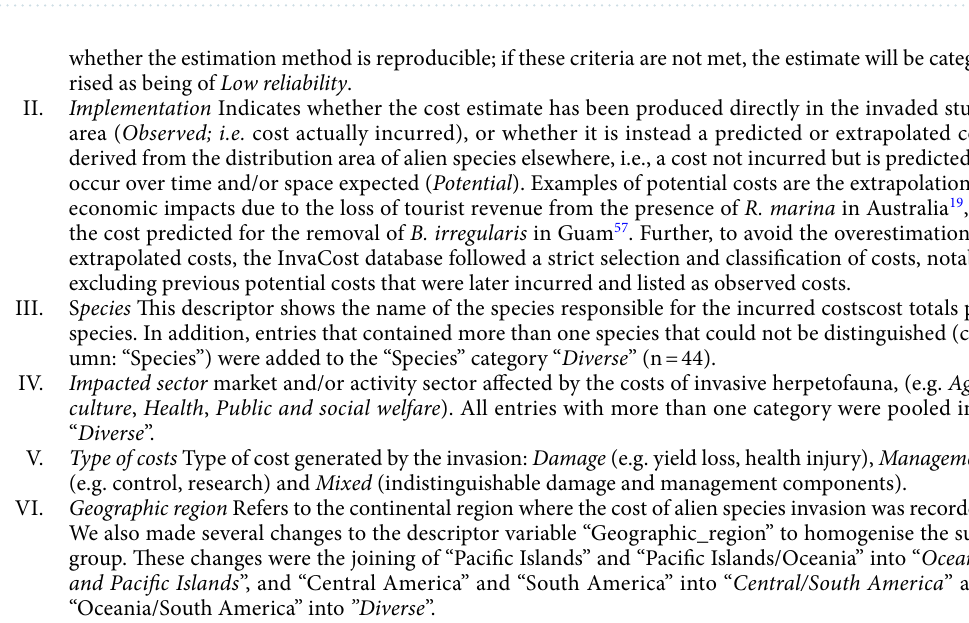
Figure 6. Diagram of the data selection and processing